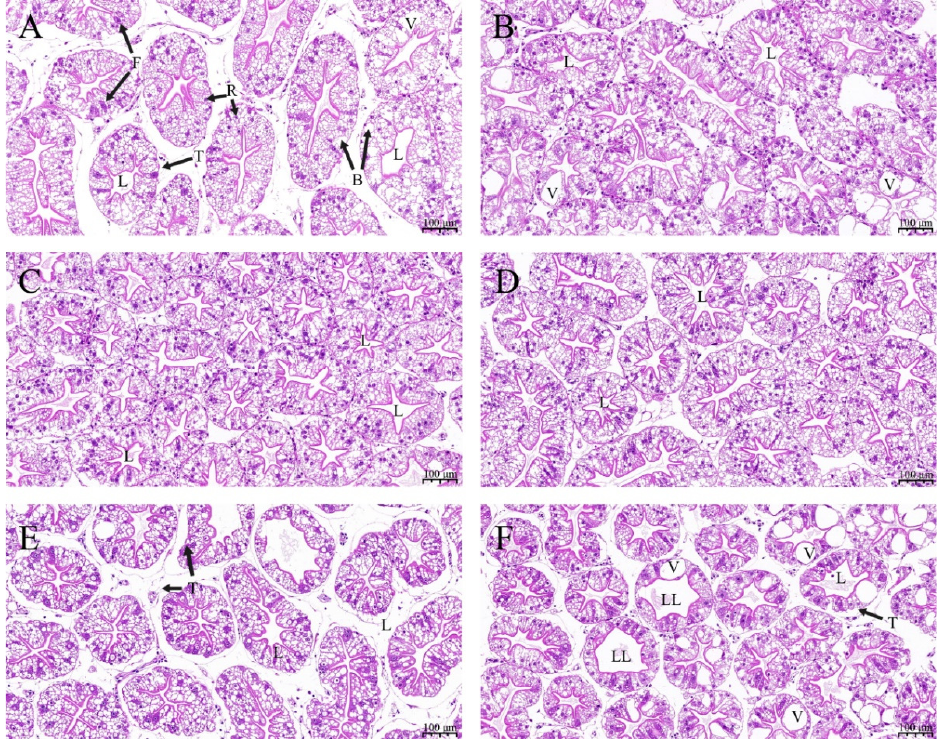
Figure 1. Hepatopancreas sections of test crayfish fed diet supplementation with different ELE levels (H&E staining 100 ×). ( A ) Hepatopancreas from crayfish fed Diet 1 (0 g dw ELE kg (dw) − 1 diet); ( B ) Hepatopancreas from crayfish fed Diet 2 (0.50 g dw ELE kg (dw) − 1 diet); ( C )